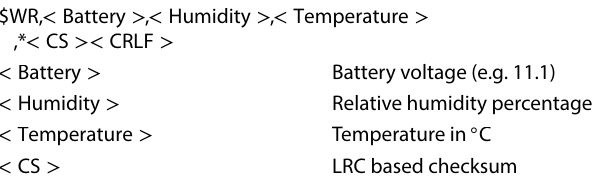
Table 3 Communications packet structure robot to PC